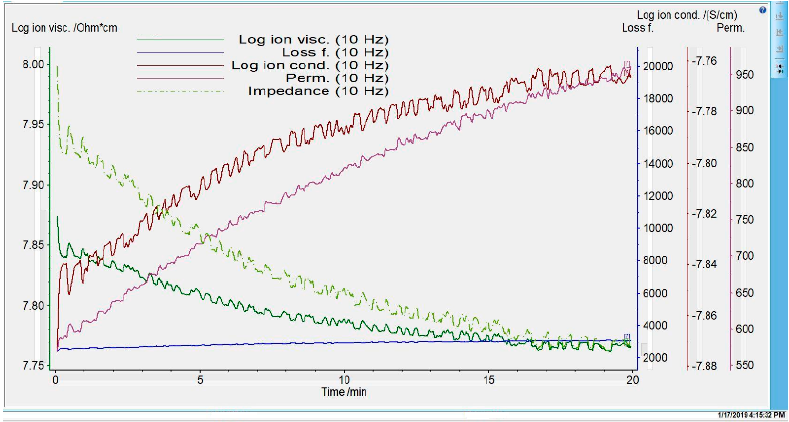
Figure 3. Evolution of electrochemical parameters of polymer film during membranes’ preforming.